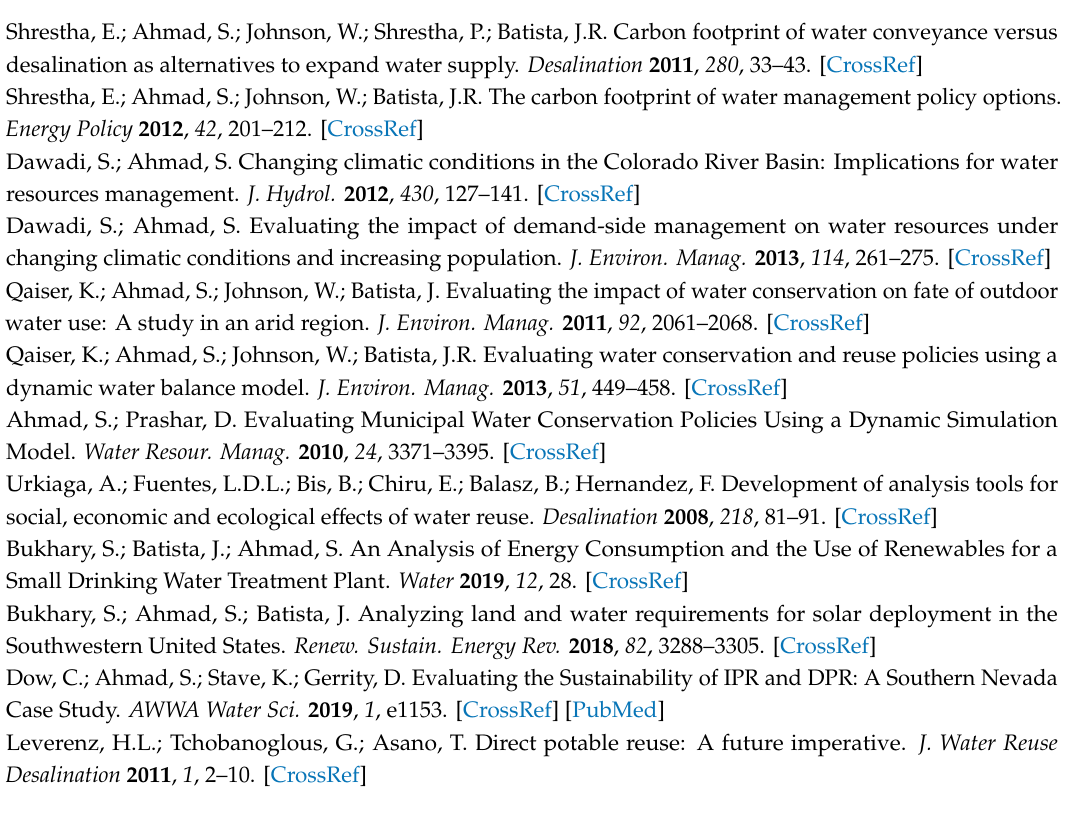
Table S1: Microbiological Parameters Used in the Activated Sludge Process Design, Table S2: Sensitivity Table of Low-End Combined Motor and Wire E ffi ciencies for Energy Consuming Units for a 23.13 m 3 / min (8.8 MGD) Water Reuse Plant, Table S3: Sensitivity Table of High-End Combined Motor and Wire E ffi ciencies for Energy Consuming Units for a 23.13 m 3 / min (8.8 MGD) Water Reuse